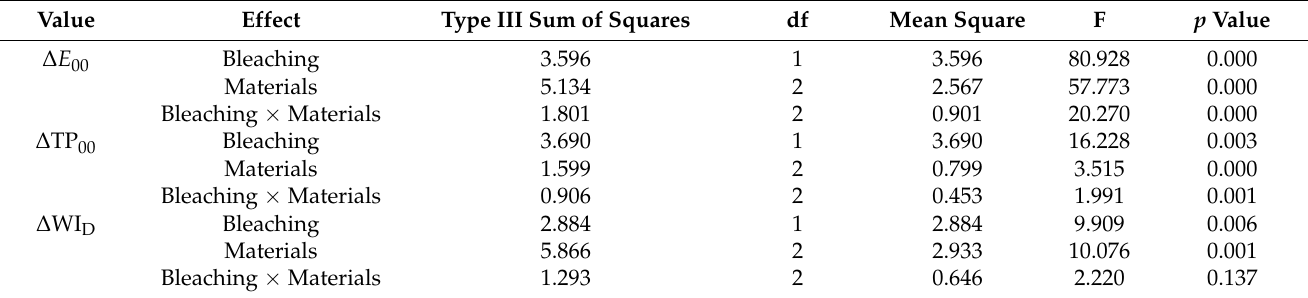
Table 2. Results of a two-way ANOVA for ∆ E 00 , ∆ TP 00 , and ∆ WI D values of all